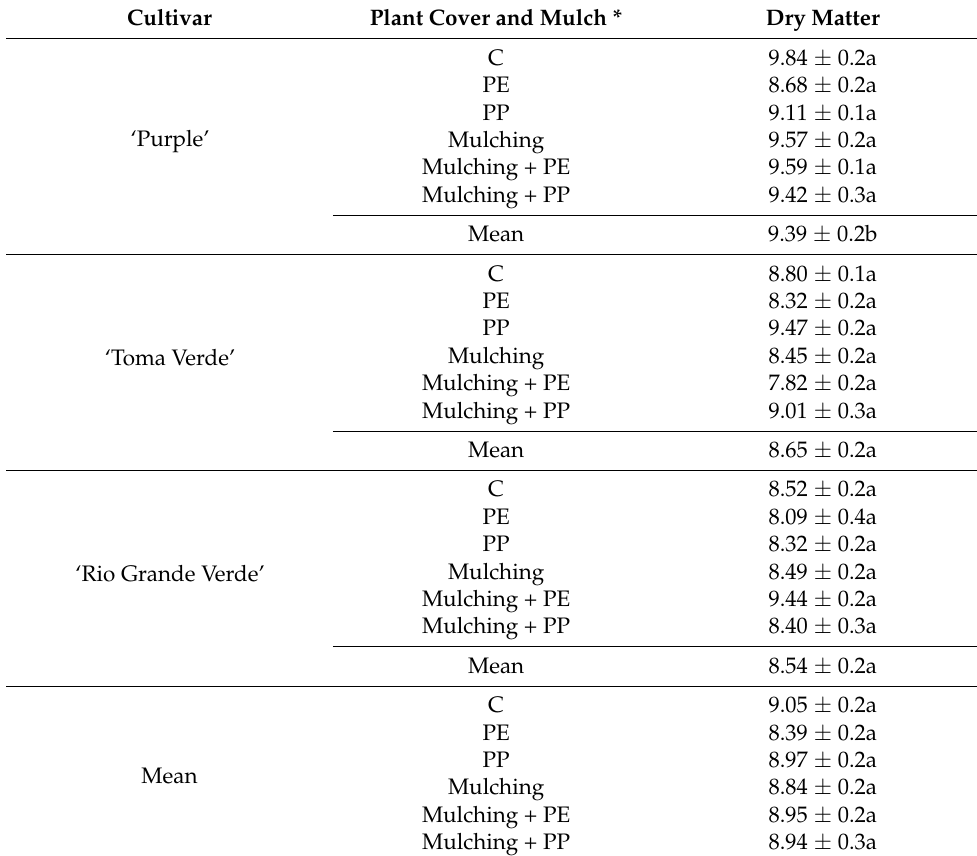
Table 11. The effects of cultivar, plant covers and mulching on the dry matter content of tomatillo fruit (%) (means of 2015,